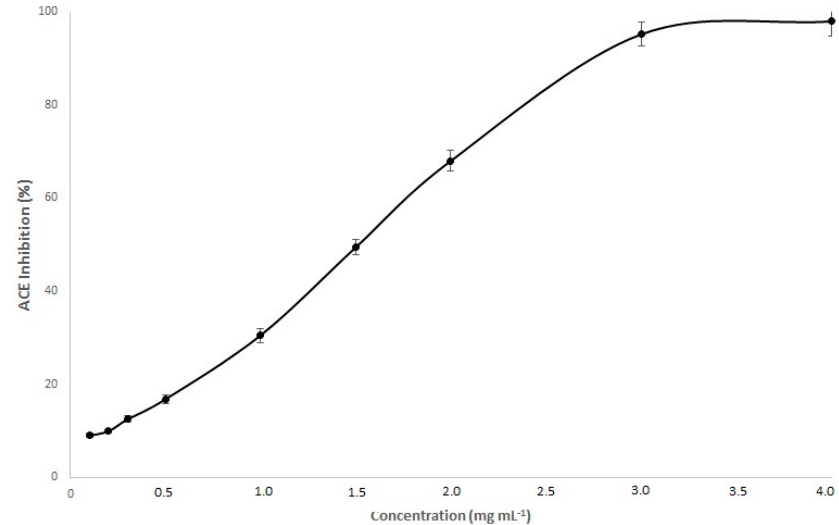
Figure 3. Dose response inhibition of angiotensin-I-converting enzyme inhibitory activity by Commandaria melanoidins.